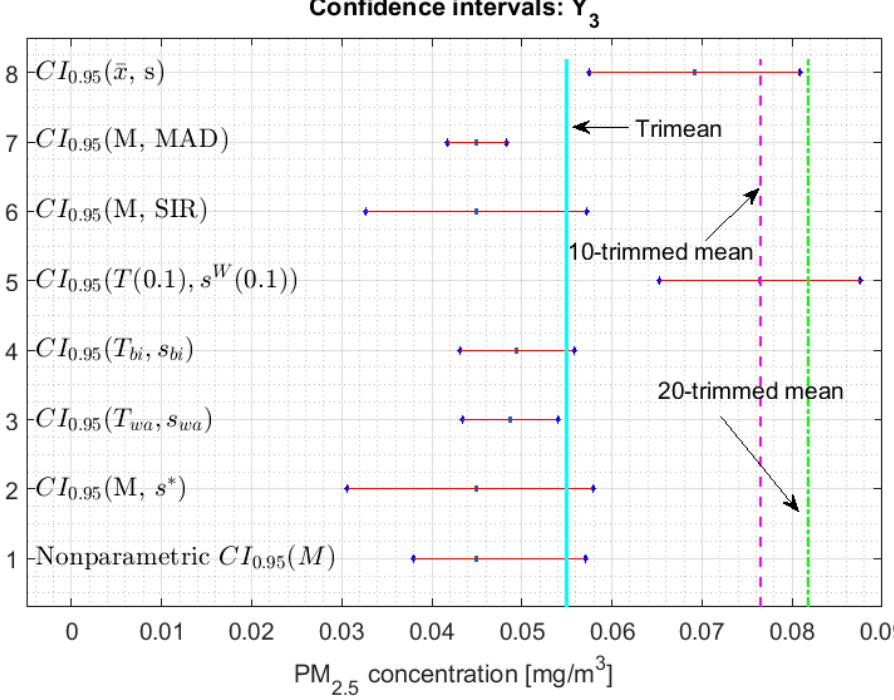
Figure 7. 95% confidence intervals ( CI 0.95 ) for robust and non-robust estimators: Y 3